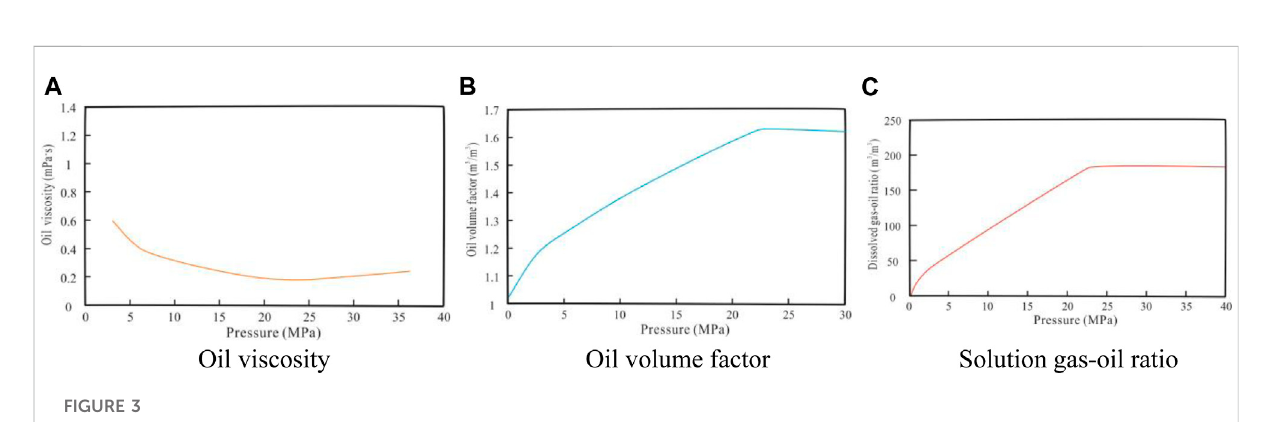
FIGURE 2 Schematic diagram of fracture distribution and discretizing for numerical simulation.